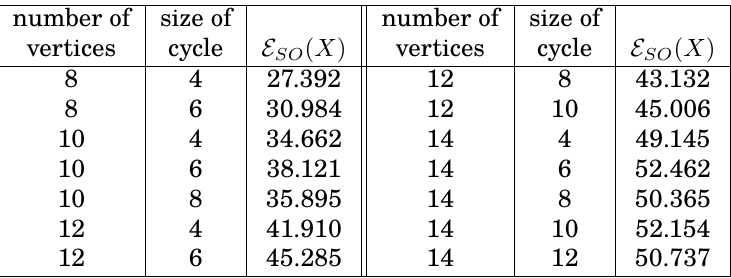
Table 1: Sombor energies of the unicyclic graphs X a,b whose structure is found in Figure 1. The H¨uckel-rule-type dependence on cycle size is clearly